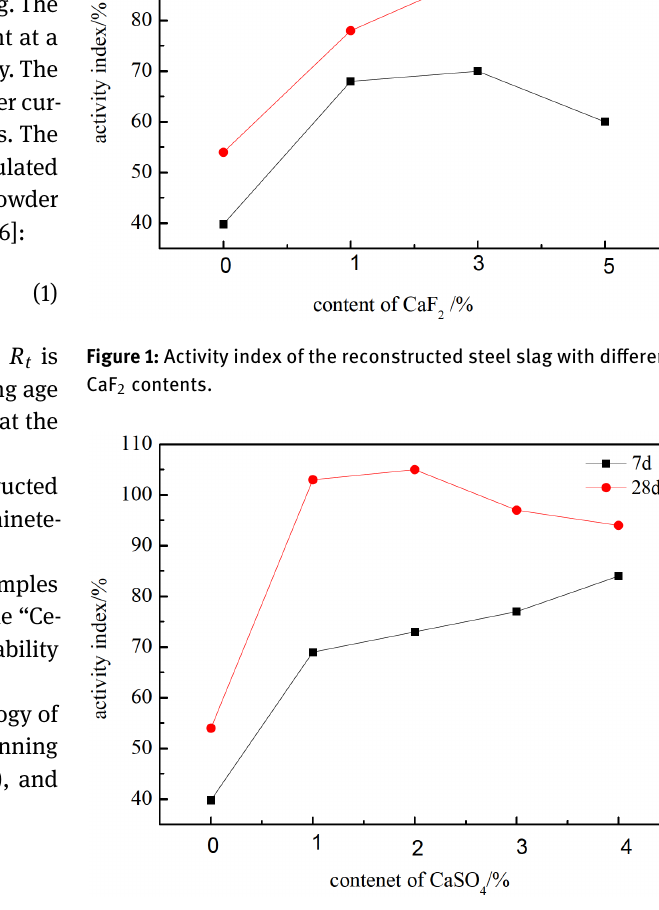
Figure 2: Activity index of the reconstructed steel slag with